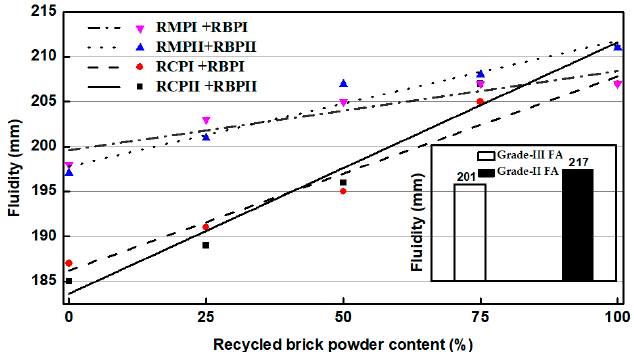
Figure 13. Results of the fluidity of mortar mixed with various RPs.